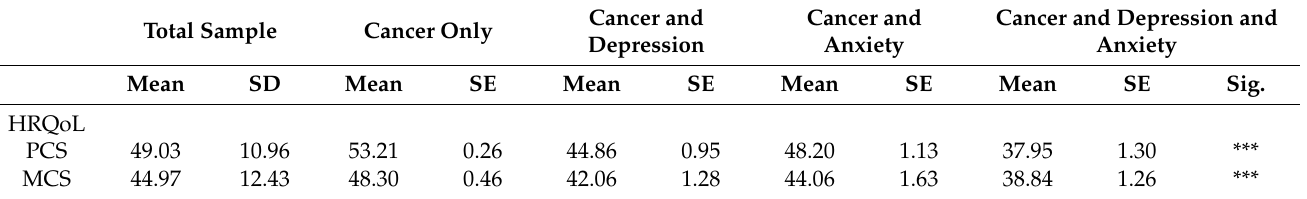
Table 2. Weighted means and standard errors of HRQoL scores by cancer groups. Adults with cancer, Medical Expenditure Panel Survey